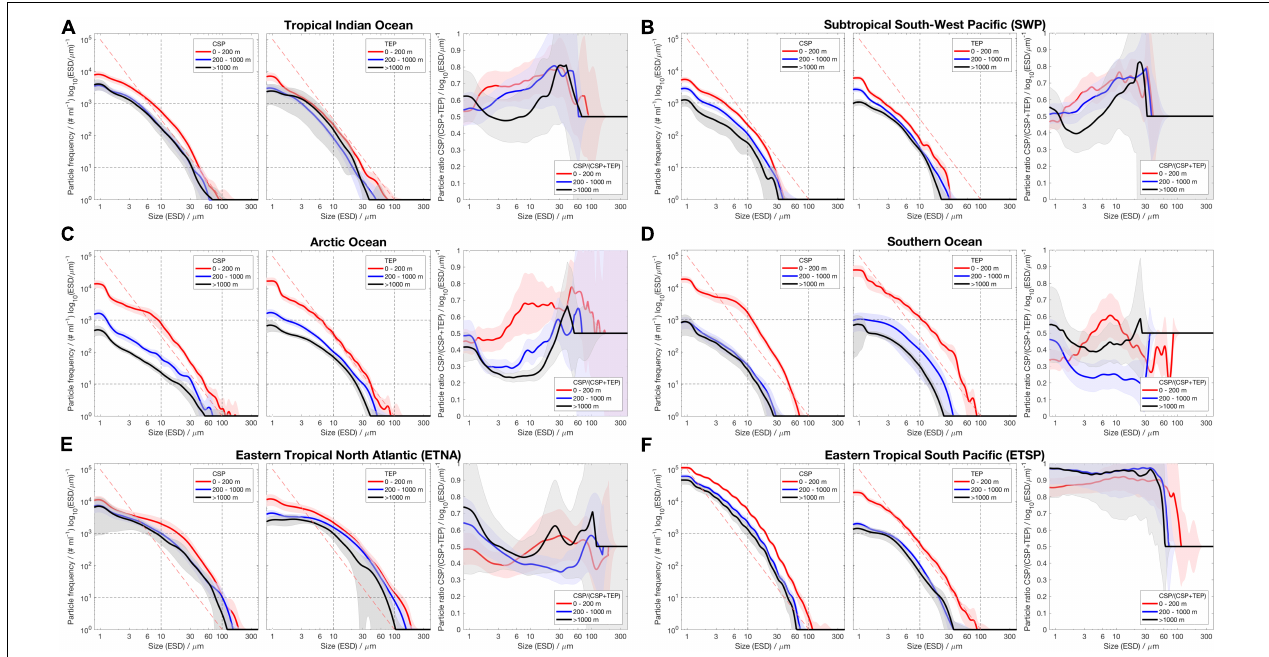
FIGURE 3 | (A–F) Average size frequency distributions of TEP and CSP within the epipelagic (red lines), mesopelagic (blue lines), and bathypelagic (black lines) ocean as well as the respective fractions of CSP over size. Gray shadings indicate the ranges of uncertainty. (A) Tropical Indian Ocean, (B) Subtropical South-West